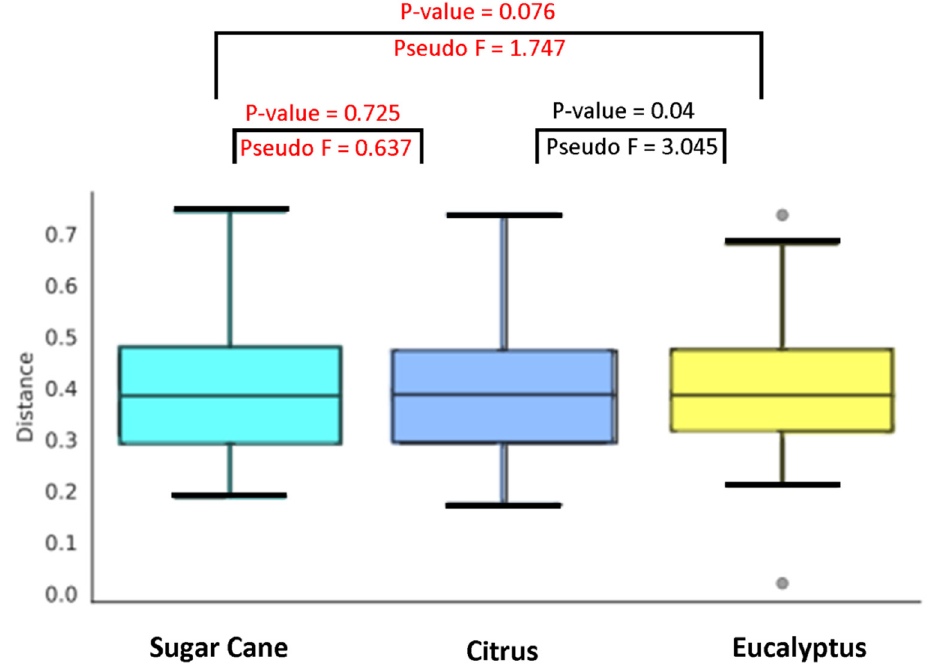
Figure 4. Pairwise permutational multivariate analysis of variance (permanova) results of agricultural sites. Results highlighted in red indicate p value greater than 0.05. Bacterial communities associated with citrus and eucalyptus agriculture contributes to the difference found in Figure 3. Table 1. Similarity percentage (SIMPER) analysis of main bacteria in citrus and eucalyptus group. This test indicates the contribution of specific ASVs to the observed differences in community structure among citrus and eucalyptus. Note that for this group, Tsukamurella is the most influential bacteria.